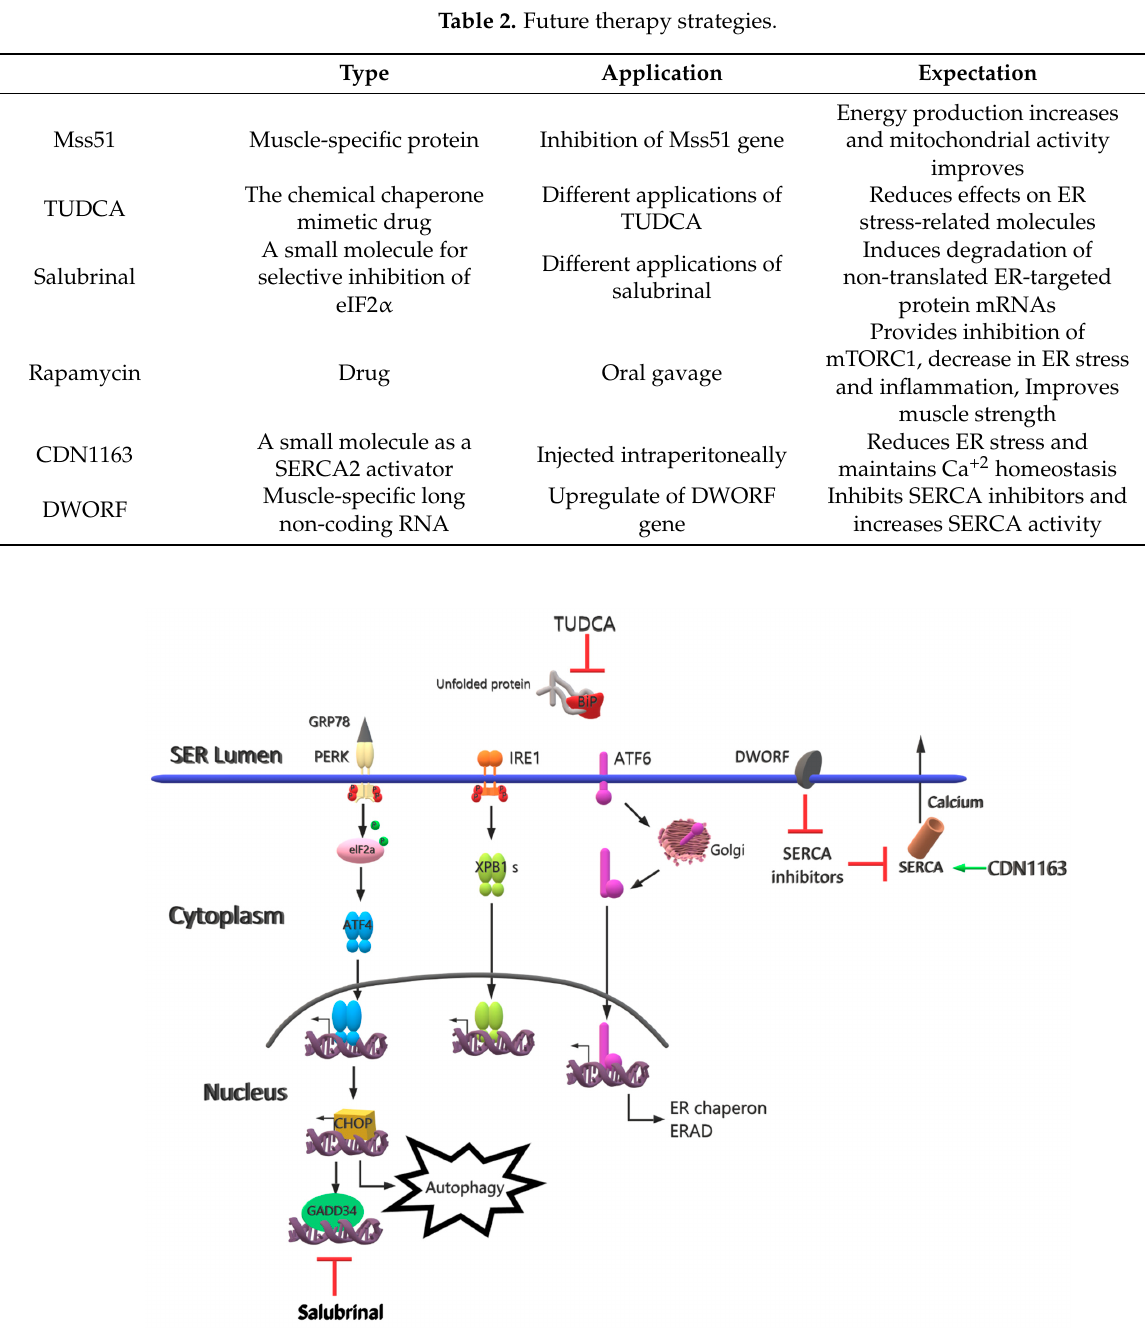
Figure 3. Future therapy strategies for LGMDR1. Calcium imbalance, thought to play a role in the pathophysiology of LGDMR1, can be repaired by inhibiting SERCA inhibitors through DWORF and by activating SERCA2 through CDN1163. ER stress can be reduced by targeting the degradation of proteins at the mRNA level through salubrinal and by preventing unfolded proteins associated with ER stress by means of TUDCA.